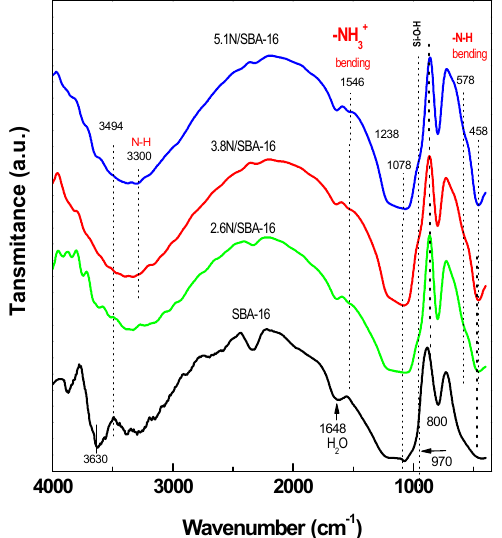
Figure 4. Fourier transform infrared spectra of the framework vibration region of the SBA-16 substrate before and after its grafting with aminopropyl groups. before and after its grafting with aminopropyl